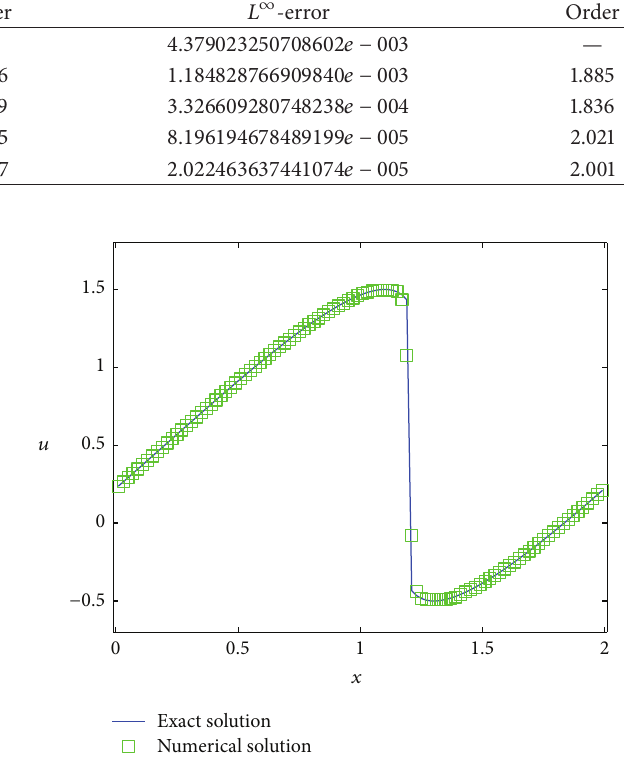
Figure 10: SHA method with TVD applied to inviscid Burgers’ equation for continuous initial value; numerical (symbols) and exact (line) solutions are compared at 𝑡 = 0.4